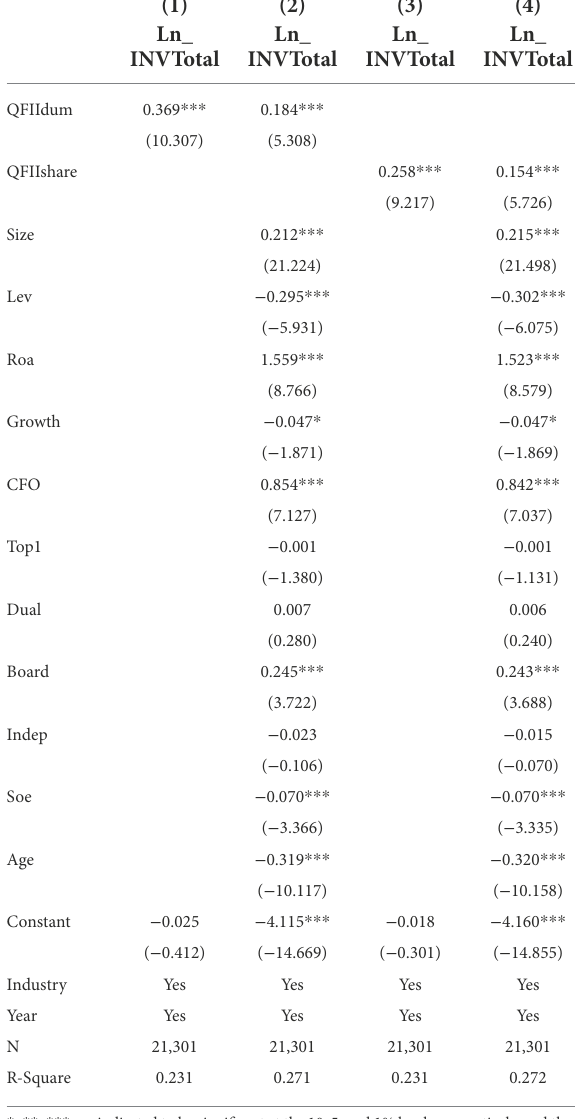
TABLE 3 Qualified Foreign Institutional Investors (QFII) and the number of corporate